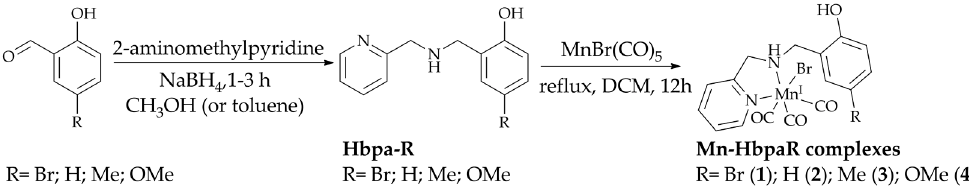
Figure 1. General schematic diagram for the synthetic procedures performed highlighting the ligands and complexes studied in this work.